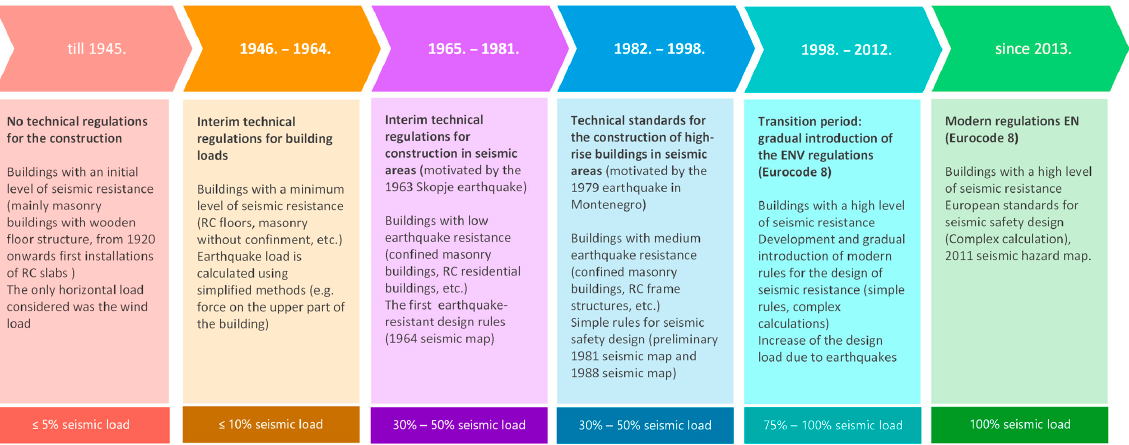
Figure 2. Development of technical regulations for seismic design in Croatia (adopted from